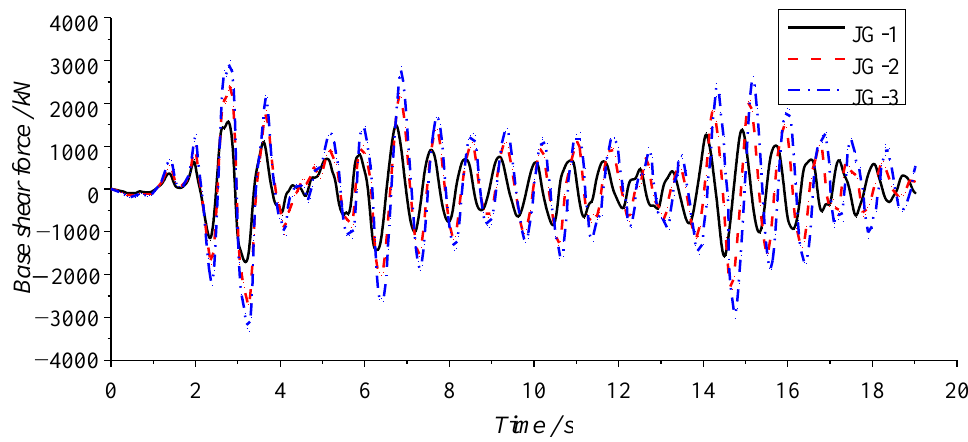
Figure 21. Comparison of base shear time-history curves of three structures.